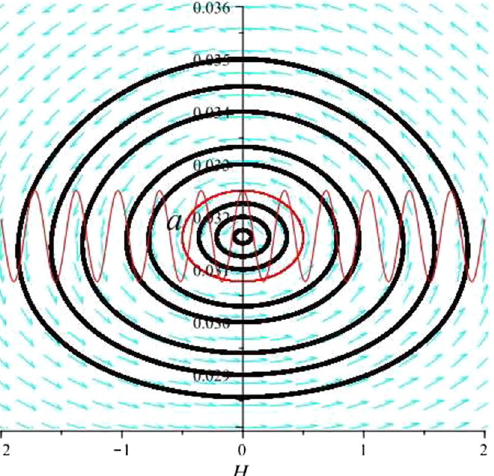
Fig. 6 Phase plane of parameters ( a , H ) for the case of k = 1, α = − 0 . 1, and β = − 0 . 1